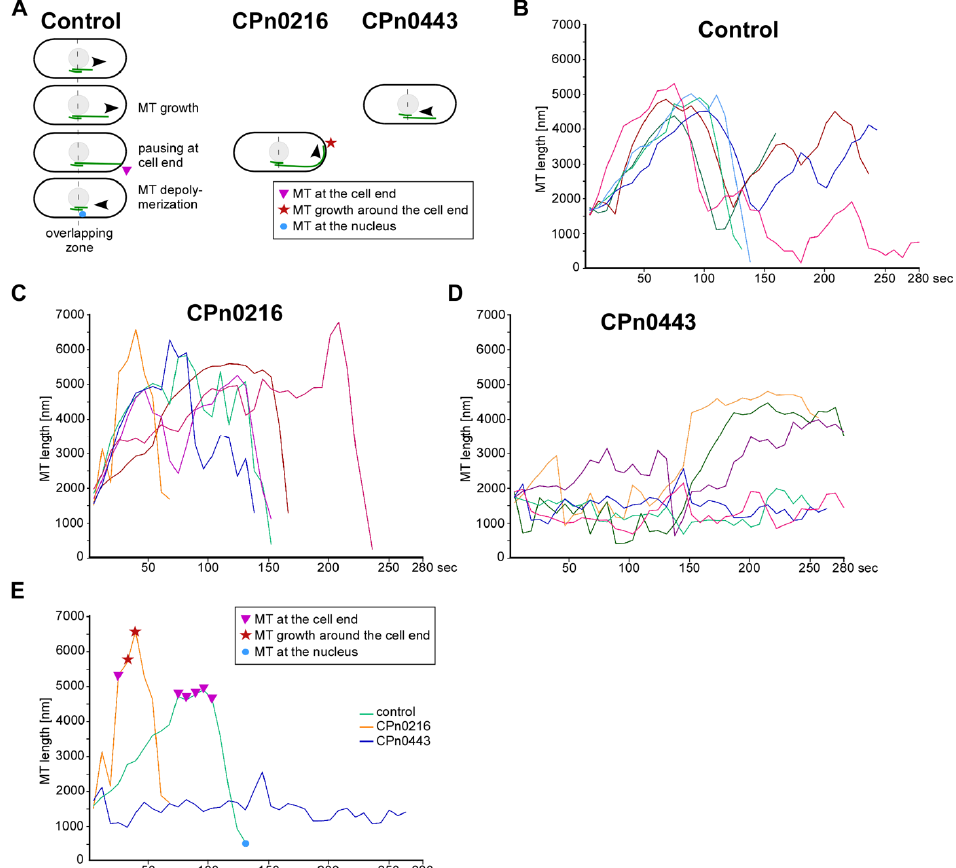
Figure 5. Expression of chlamydial CPn0216 or CPn0443 proteins altered the MT dynamics in yeast. ( A ) Diagrammatic representation of wild-type MT dynamics of an S. pombe interphase cell (control cells) and the main differences observed in yeast transformants that expressed CPn0216 or CPn0443. Interphase MTs from control cells polymerized from the vicinity of the nucleus in an oriented manner along the long cell axis to the cell end, then paused (pink triangle) and depolymerized back to the nucleus (blue dot). MTs of CPn0216 expressing cells did not stop polymerization once the cell end was reached but continued to grow around the cell end, resulting in a “curling” phenotype (red star), while the MTs of CPn0443 expressing cells depolymerize before reaching the cell end. ( B – D ) Examples of the dynamic behavior of individual interphase MTs from the control, CPn0216- or CPn0443-expressing cells that demonstrated consistently aberrant MT dynamics caused by the expression of a chlamydial protein. Each color represents MT dynamics for individual MTs from cells transformed with the indicated plasmid. ( E ) Representative examples of the dynamic behavior of a single MT from either a control, CPn0216- or CPn0443-expressing cell. The MT dynamics of MTs that were 1.5–2 µm in length (from the middle of the MT overlap zone at the nucleus) were measured via live-cell imaging of GFP- α -tubulin-expressing transformants.